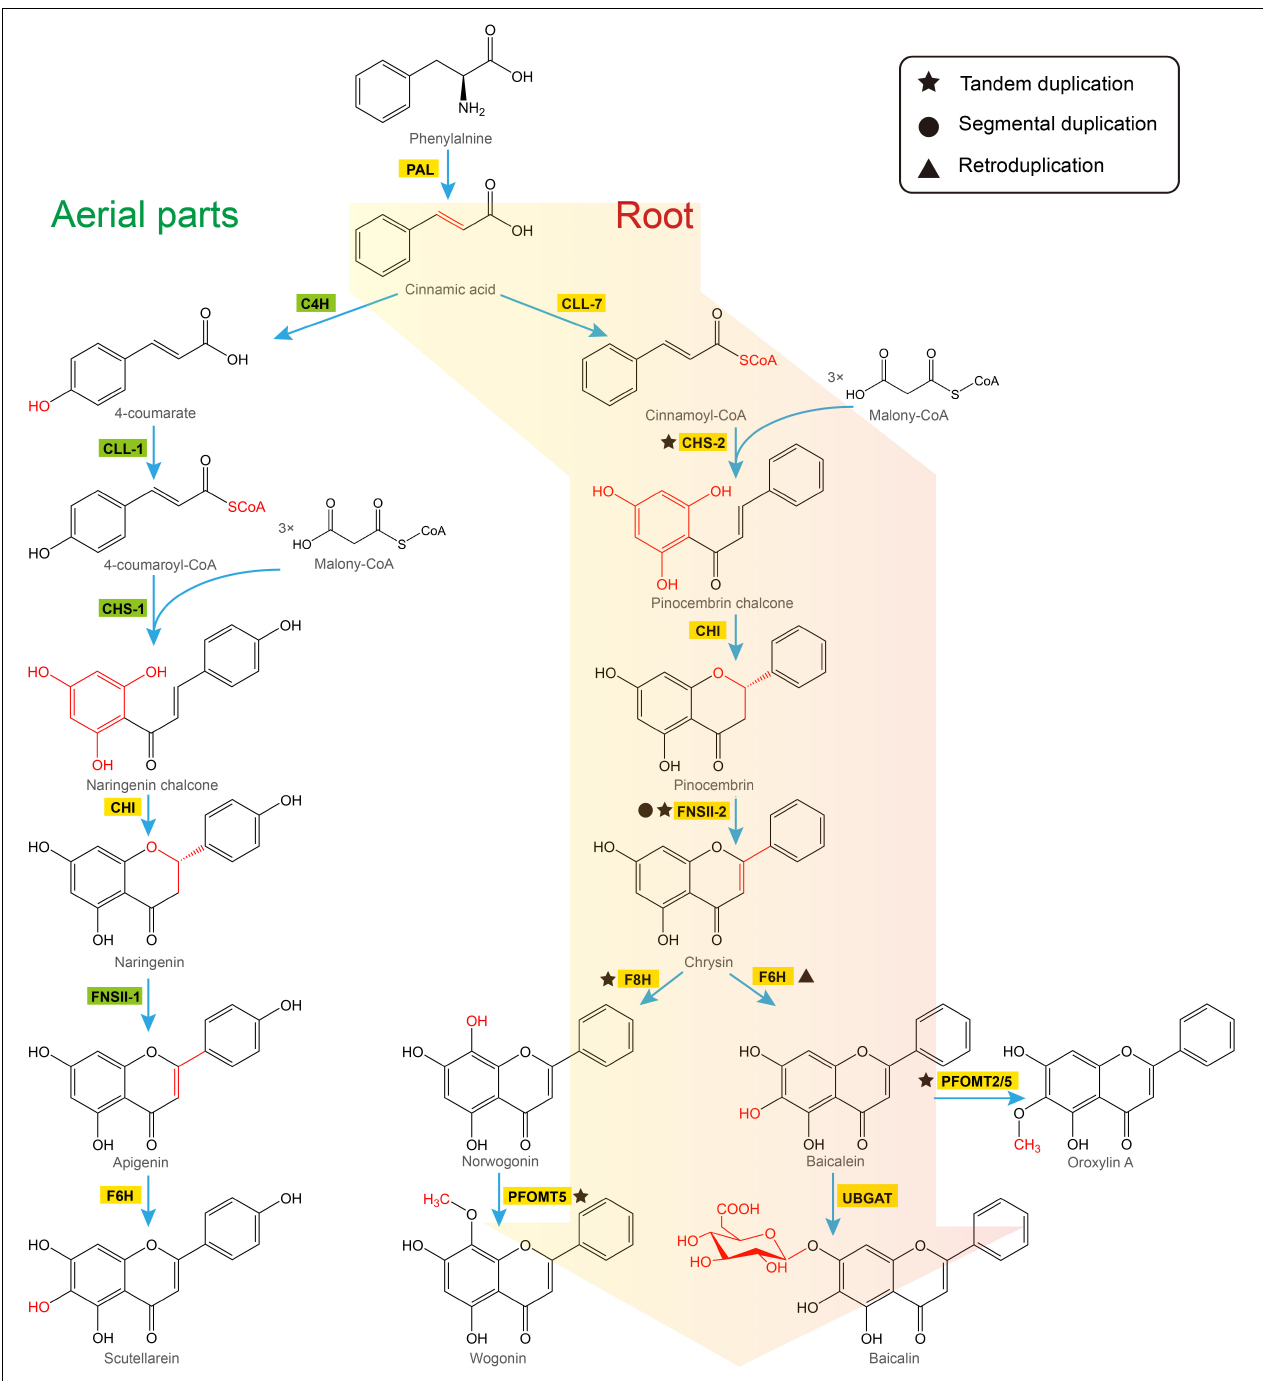
FIGURE 2 | Two pathways responsible for biosynthesis of flavones in Scutellaria baicalensis . The classic flavone pathway makes scutellarein in aerial tissues (left hand), while 4 (cid:48) -deoxyRSFs are produced by a newly evolved pathway in roots (right hand). PAL, phenylalanine ammonialyase; C4H, cinnamate 4-hydroxylase; CLL-7, cinnamate-CoA ligase; CLL-1, 4-coumarate CoA ligase; CHS, chalcone synthase; CHI, chalcone isomerase; FNSII, flavone synthase II; F6H, flavone 6-hydroxylase; F8H, flavone 8-hydroxylase; PFOMT, flavonoid O -methyltransferases; UBGAT, baicalein 7- O -glucuronosyltransferase.